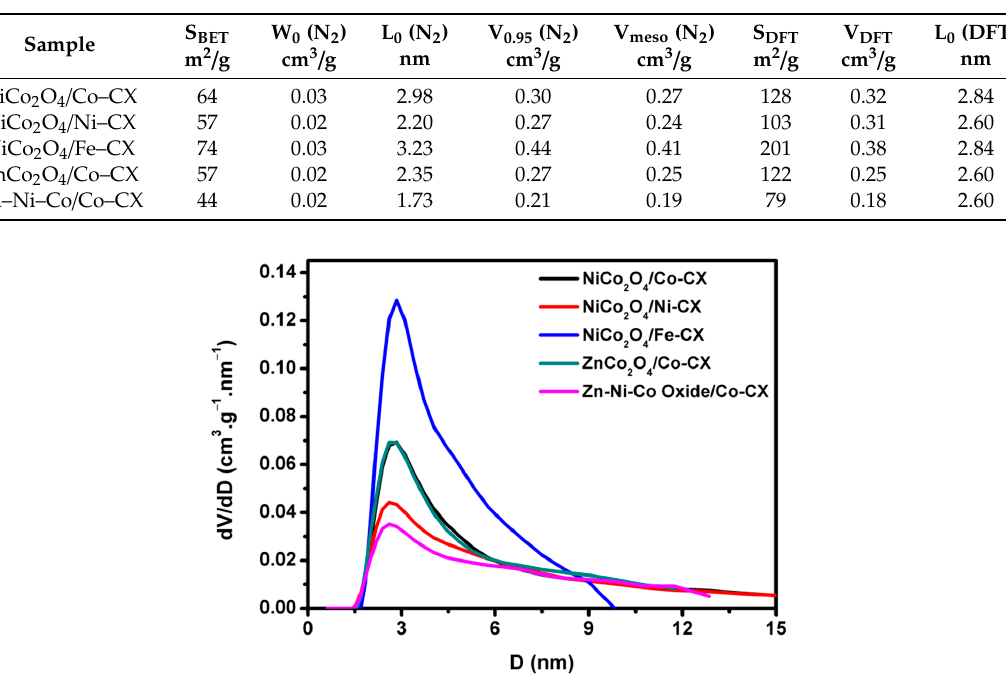
Table 1. Textural characteristics of the samples.